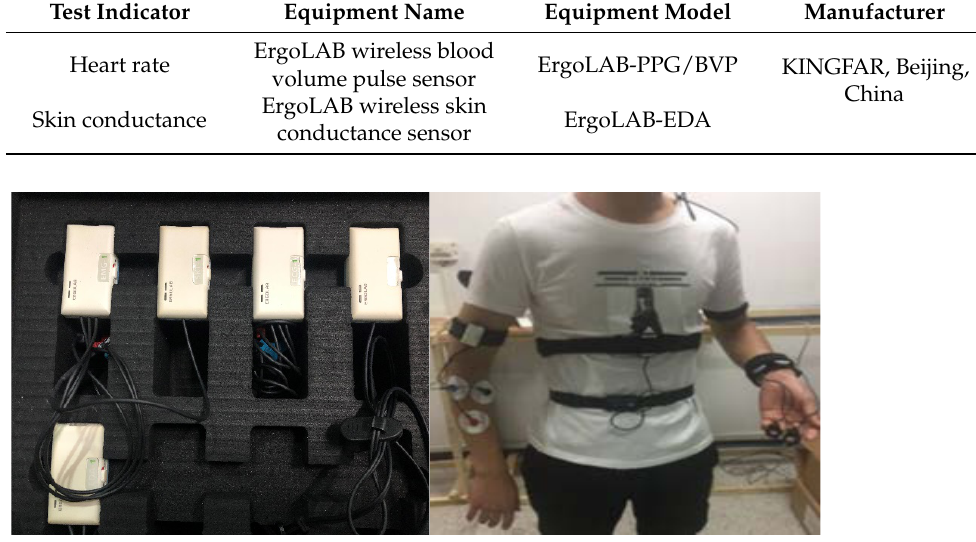
Figure 2. ErgoLAB wireless physiological sensors and participants wearing wireless physiological sensors .